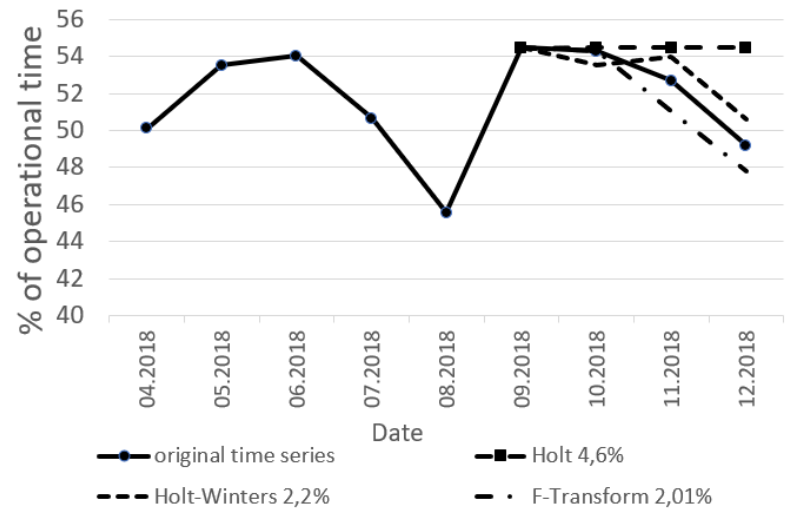
Figure 6. Forecast of % of operational time of department.